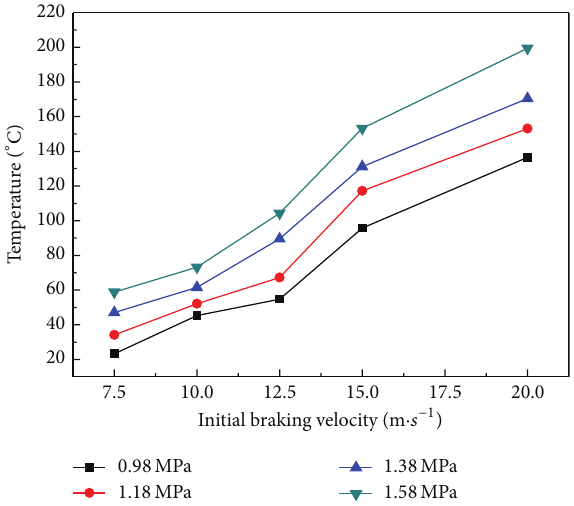
Figure 12: Variations of the mean surface temperature with braking